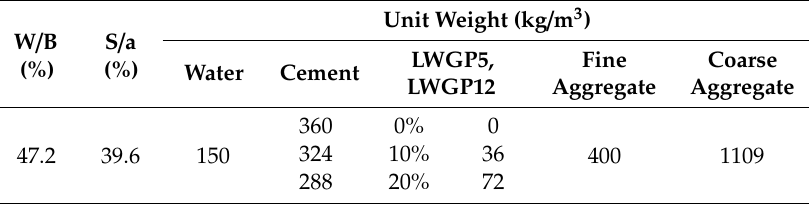
Table 3. Mixing proportions of the reinforced concrete flume with the LWGP.